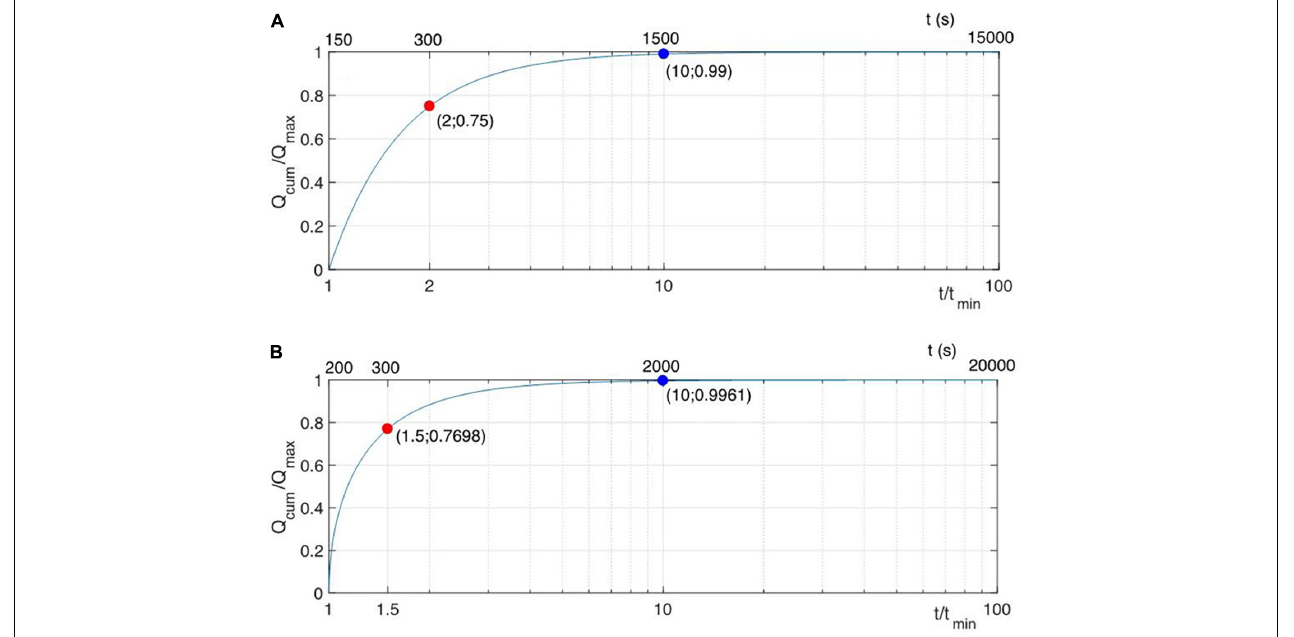
FIGURE 11 | Relationships between normalised cumulative volumetric flow and normalised ascent time for a fully-developed laminar flow in a cylindrical conduit (A) and in a dike (B) . The red dots are plotted for the average ascent time, while the blue dots for a time 10 times larger than the minimum ascent time. A non-normalised time scale is also reported on the top of each plot, where the average ascent time has been fixed to 300